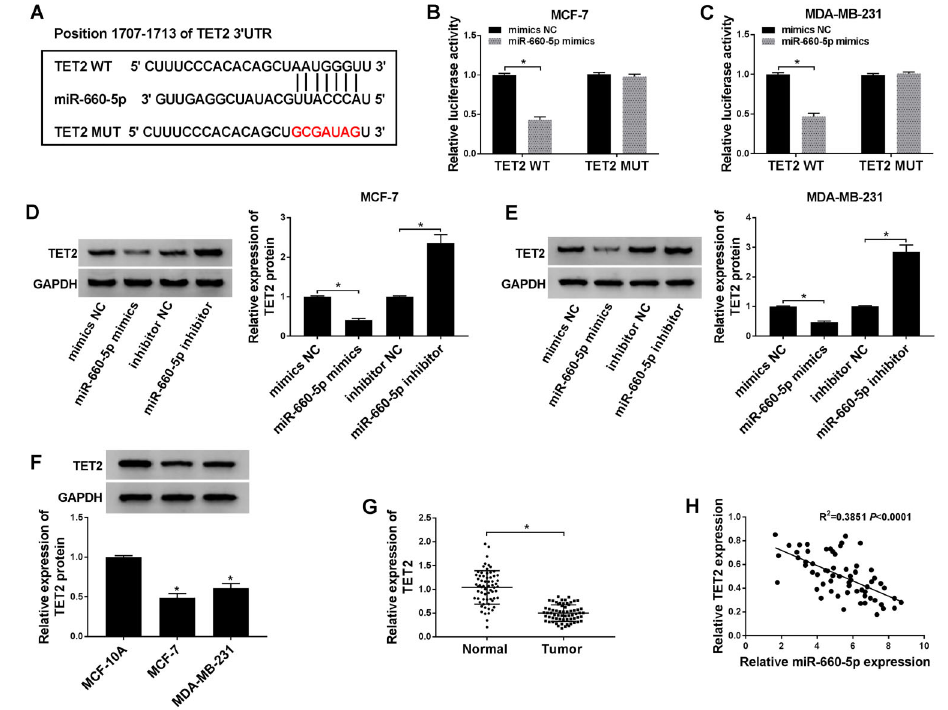
Figure 3. A , The binding sites between miR-660-5p and TET2 were predicted by TargetScan online software. B and C , Luciferase activity was determined in MCF-7 and MDA-MB-231 cells (n=3) co-transfected with TET2 wild type (WT) or TET2 mutant (MUT) and mimics negative control (NC) or miR-660-5p mimics for 48 h. D and E , The expression level of TET2 was measured in breast cancer (BC) cells (n=3) transfected with mimics NC, miR-660-5p mimics, inhibitor NC, or miR-660-5p inhibitor for 24 h by western blot. F , The enrichment of TET2 was detected in BC cells (n=3) and normal human breast epithelial cells MCF-10A (n=3) by western blot. G , The expression of TET2 was measured in BC (n=65) and normal tissues (n=65) by qRT-PCR. H , The relationship between the expression of miR-660-5p and TET2 was analyzed in BC tissues. Data are reported as means ± SD. *P o 0.05 (Student ’ s t -test and ANOVA).